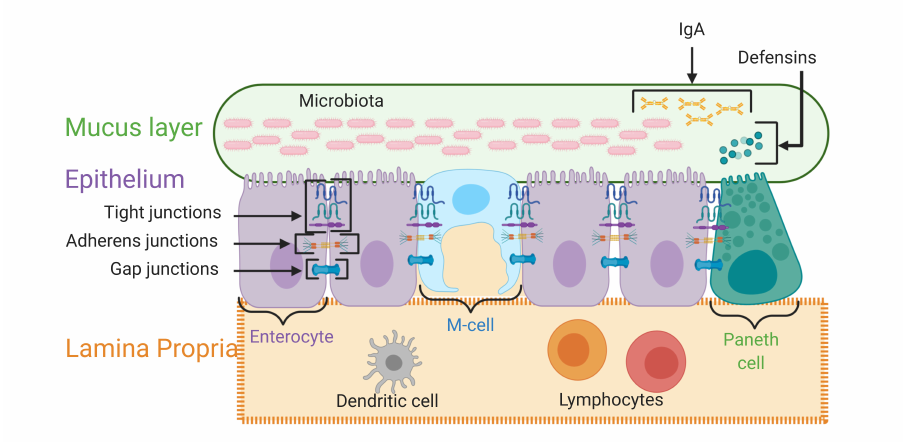
Figure 1. This figure outlines the key layers of the intestinal barrier. The mucus layer is composed of mucin proteins, but this layer also contains IgA antibodies, defensins and a proportion of the intestinal microbiota. The epithelial layer contains many specialized cell types, including enterocytes, microfold cells (M-cells) and Paneth cells, amoung others. The cells in this layer are connected by transmembrane protein complexes. The lamina propria is a connective tissue layer that contains immune cells, blood vessels and lymphatic vessels. Figure created with